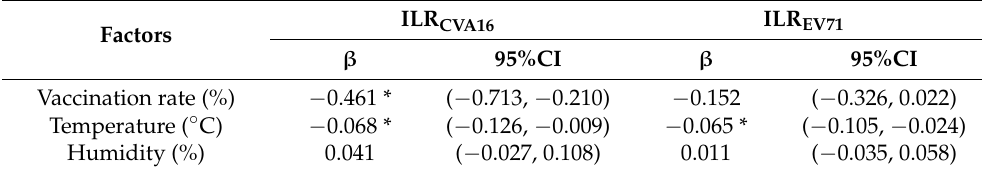
Table 3. Multivariate linear regression of HFMD genotype frequency on vaccination rate and climate factors.